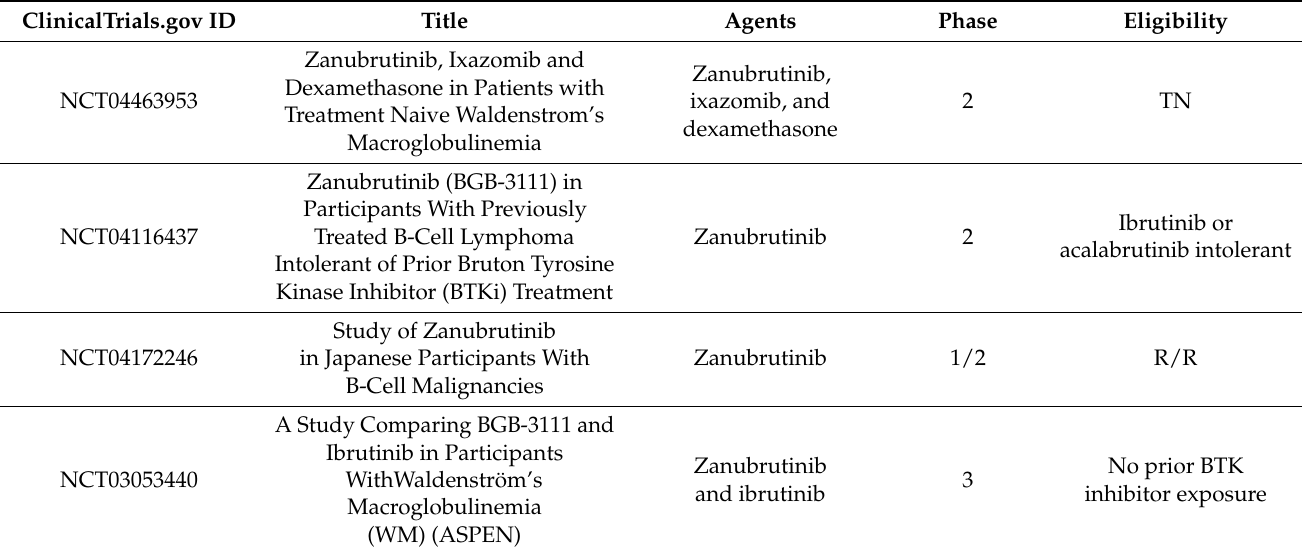
Table 1. Ongoing clinical trials of zanubrutinib in patients with Waldenström macroglobulinemia. ClinicalTrials.gov